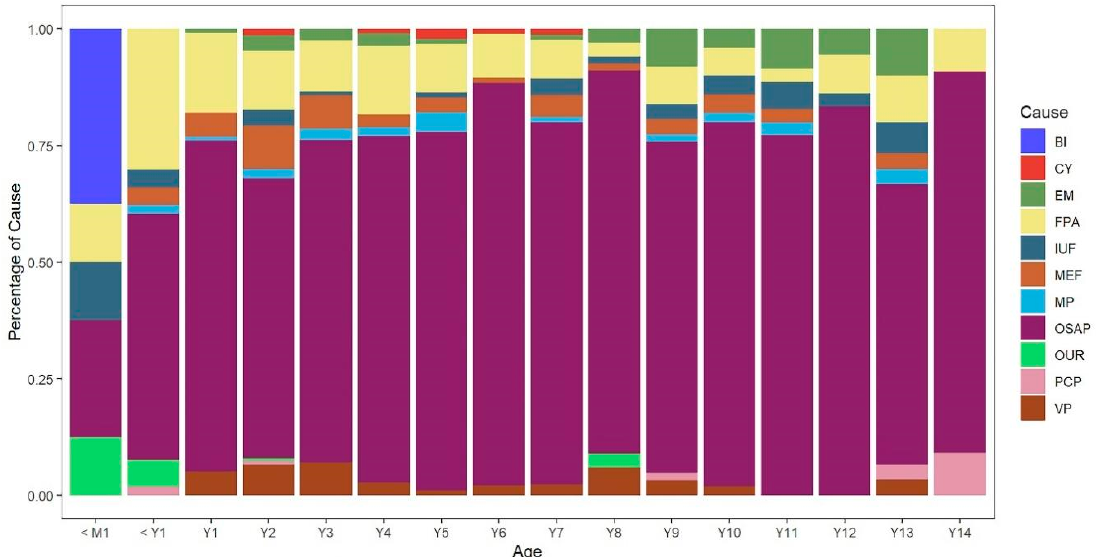
Figure 6. The proportion of different causes in all ages of children. Legend: Birth injury (BI); excise machine injury (EM), referring to falling with greater momentum involving sports equipment referring to skating, skiing, rollerblading, skateboarding or bicycle riding, etc.; falling from one plane to another (FPA), referring to bed, chair, sofa, stairs or steps, etc.; falling on the same plane (OSAP), referring to slip, trip, etc., with small momentum; improper use of force (IUF), referring to repetitive motion or over-exertion, etc.; mechanical force (MEF), referring to exposure to tools and instruments involving knives, glass, door gap, falling object, or lifting device, etc.; cyclist injury (CY), referring to bicycle colliding accident except collapsing with a car; motorcycle passenger injury (MP), referring to passengers or pedestrians in motorcycle accidents; vehicle passenger injury (VP), referring to passengers or pedestrians in vehicle accidents; physical contact with people (PCP); other unexpected reasons